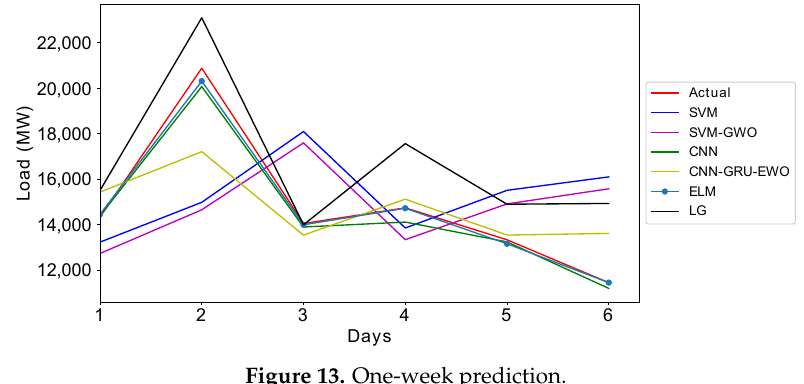
Figure 13. One-week prediction.